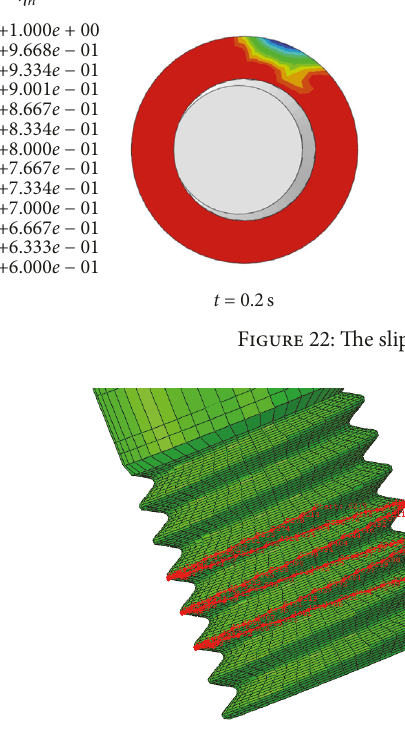
Figure 23: The schematic diagrams of helical segments.